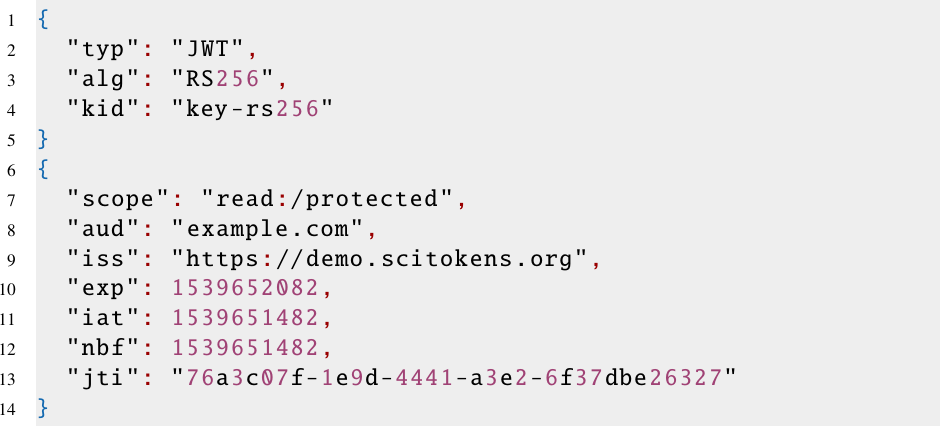
Figure 2. Example